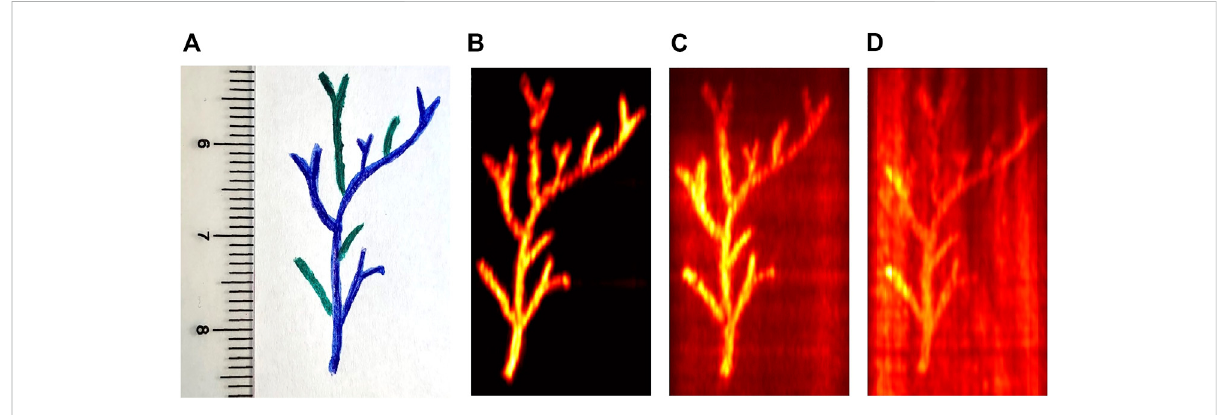
FIGURE 4 Vessel-mimicking phantom shape (A) and the single wavelength photoacoustic images acquired at 700 nm for the three phantoms with differentlevels ofabsorbing background.Speci fi cally, without India Ink (B) , with 0.05%v/v IndiaInk (C) , andwith 0.1% v/v IndiaInk (D) as background